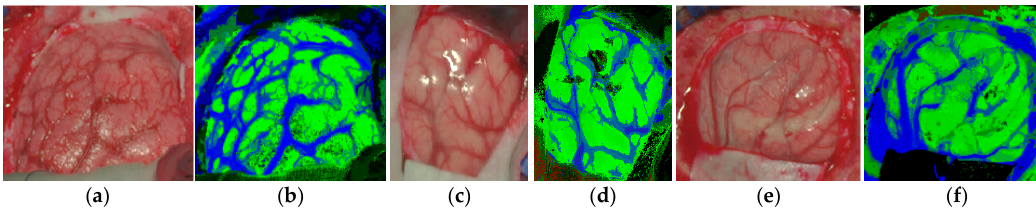
Figure 9. Normal brain image results obtained from the validation database employing the HELICoiD demonstrator: ( a , b ) synthetic RGB image and TMD map of the P1C1 HS image; ( c , d ) synthetic RGB image and TMD map of the P2C1 HS image; ( e , f ) synthetic RGB image and TMD map of the P3C1 HS image. Sensors 2018 , 18 , x FOR PEER REVIEW